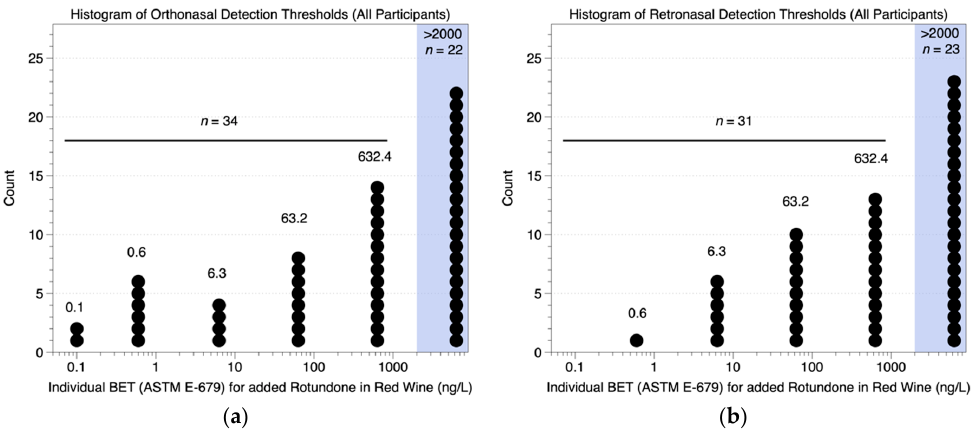
Figure 1. Estimated detection thresholds for rotundone in red wine assessed via the nostrils (orthonasal; ( a )) or via mouth (retronasal; ( b )) using the standard ASTM E679 method.